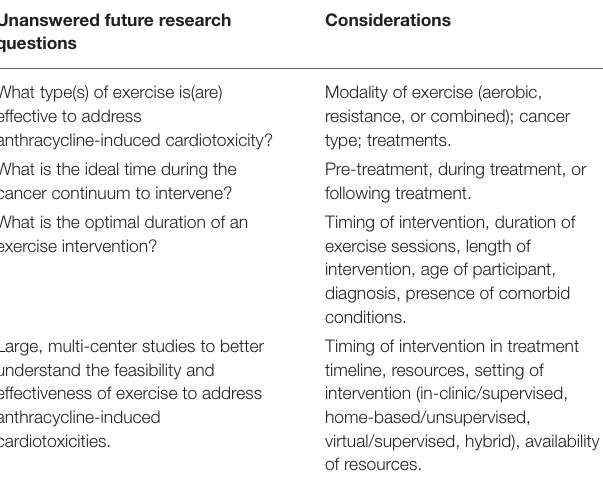
TABLE 4 | Research questions and considerations for future